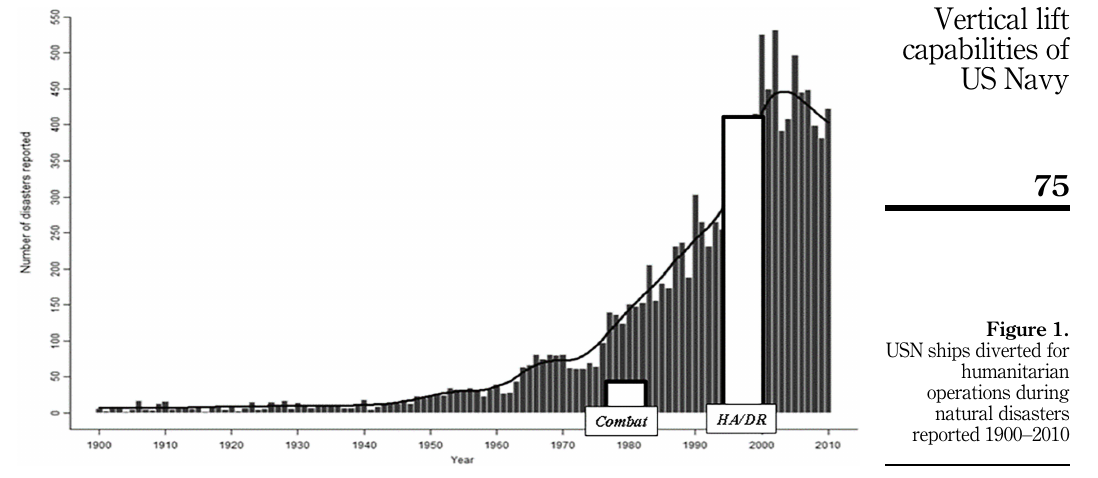
Figure 1. USN ships diverted